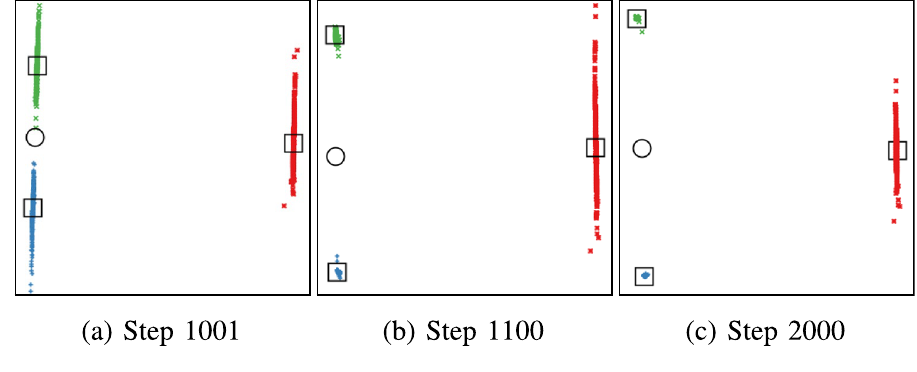
Fig. 4 The plots show the effect of the projected compression loss after splitting the left leaf the data points on the left are compressed into two distinctive clusters, whereas the single leaf node on the right still preserves its orthogonal